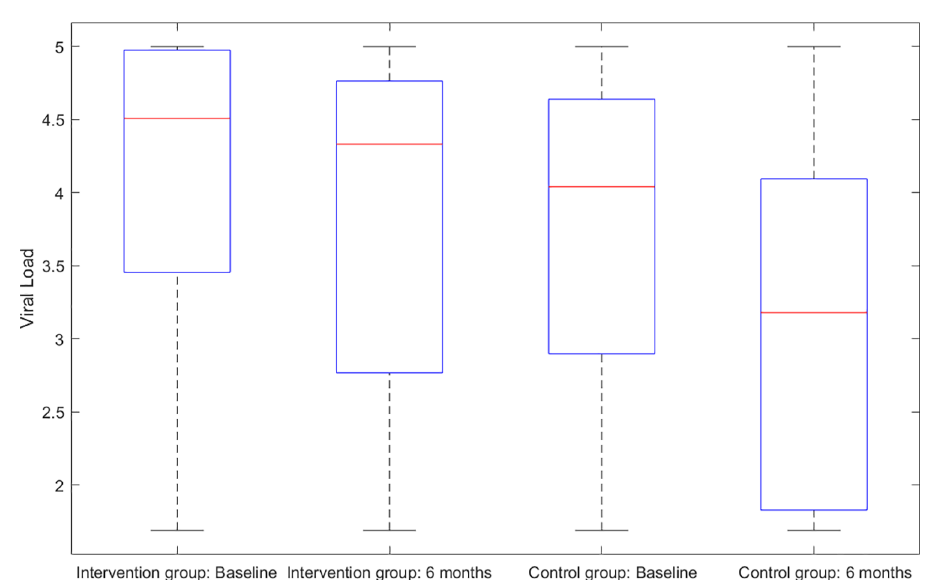
Fig 4. Boxplots of visual load for treatment and control groups at baseline and 6-month visits.